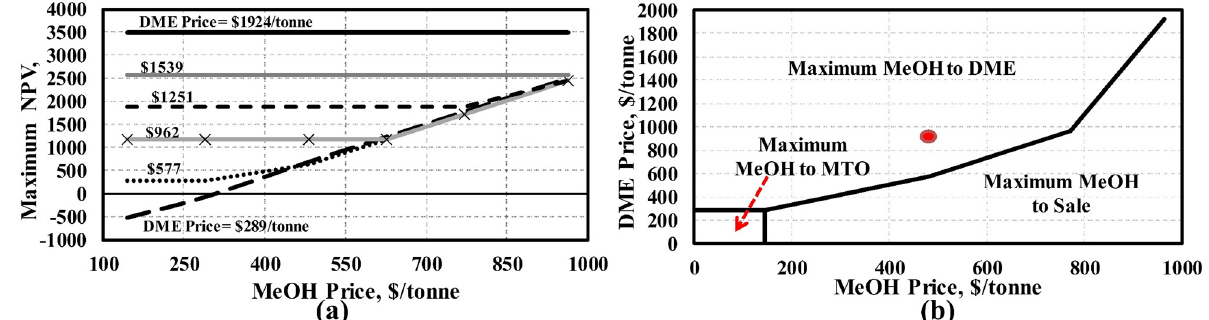
Figure 4. Effect of MeOH and DME price on ( a ) the maximum NPV of process; ( b ) optimal product portfolio (Fayetteville shale gas). The location of the chosen base case market conditions is indicated as a red